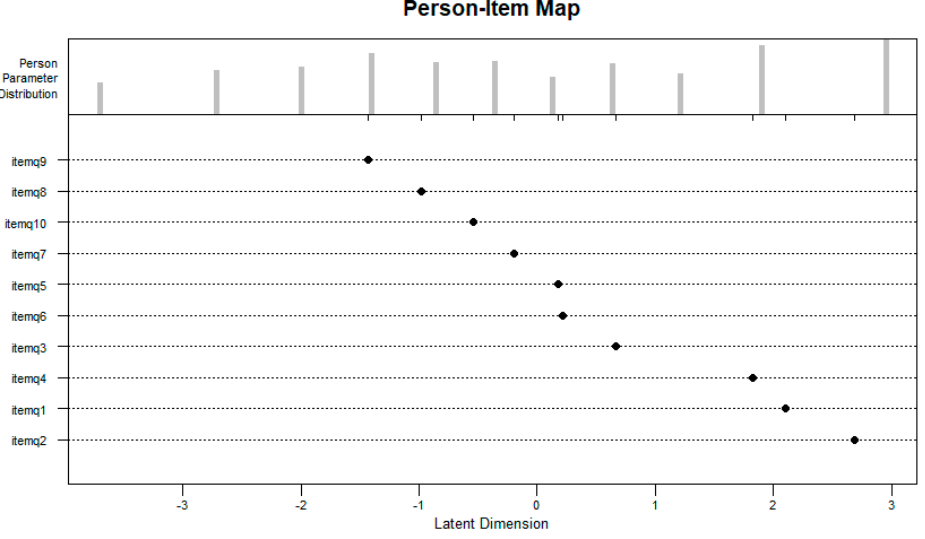
Figure 5. This person–item map based on the Rasch model.